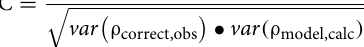
acids of interest was extracted. The size and grid of the cubes were arbitrarily determined and were the same for all the residues.